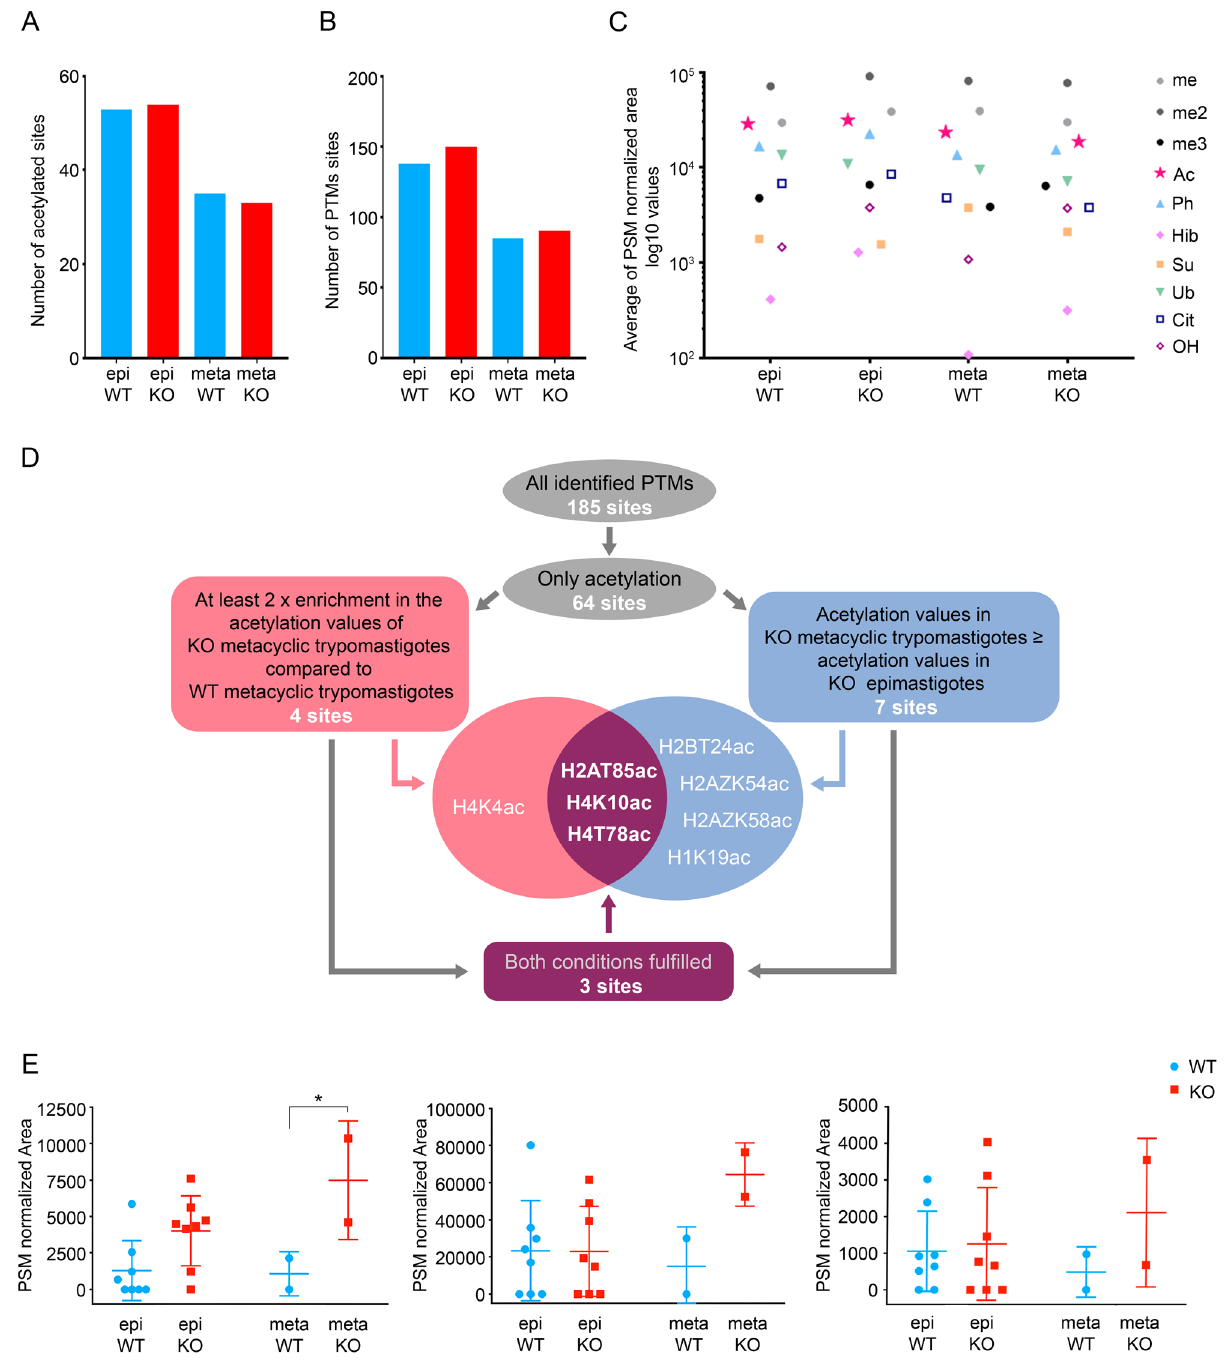
Figure 5. Tc HDAC4 histone post-translational modifications targets. ( A ) Number of distinct acetylation sites identified for each condition. ( B ) Numbers of distinct PTMs identified for each condition. ( C) Comparison of the global PTM levels in epimastigotes (epi) and metacyclic trypomastigotes (meta) from wild type (WT) and mutant (KO) cells using the average of the peptide intensity (me, monomethylation; me2, dimethylation; me3 trymethylation; Ac, acetylation; Ph, phosphorylation; Hib: 2-hydroxyisobutyrylation; Su: succinylation; Ub: ubiquitination; Cit: citronylation; OH: hydroxylation). ( D ) Flowchart describing the steps to determine the potential acetylation sites modulated by Tc HDAC4 in T. cruzi metacyclic trypomastigotes. ( E ) Acetylation levels of the putative Tc HDAC4 specific target sites. The graph shows the PSM normalized area of the peptide intensity for the peptides containing acetylated threonine 85 in histone H2A (H2AT85Ac), acetylated lysine 10 in histone H4 (HK410Ac) and acetylated threonine 78 in histone H4 (H4T78ac). *indicates p value =